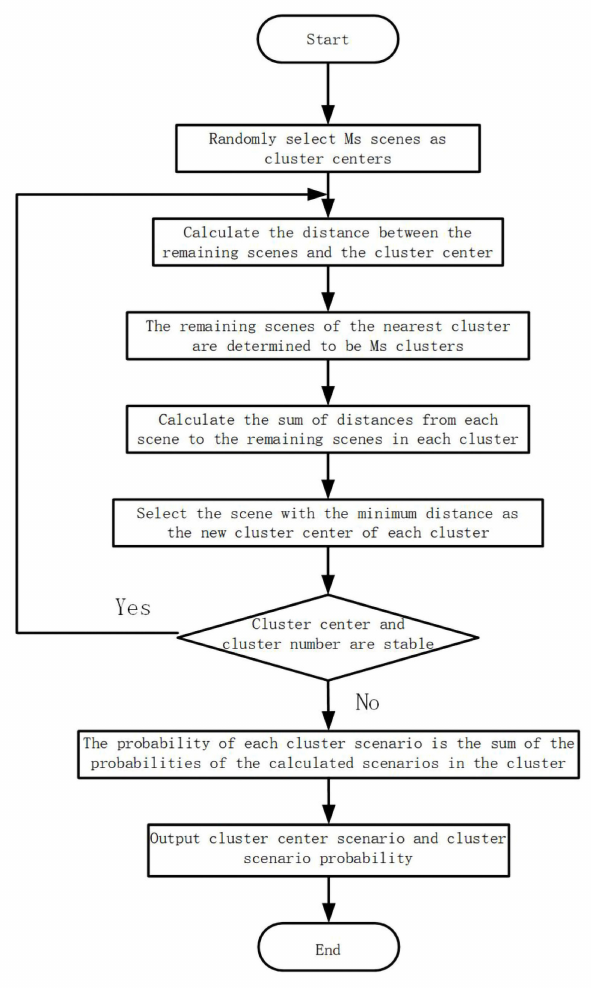
Figure 3. Cluster reduction flowchart.